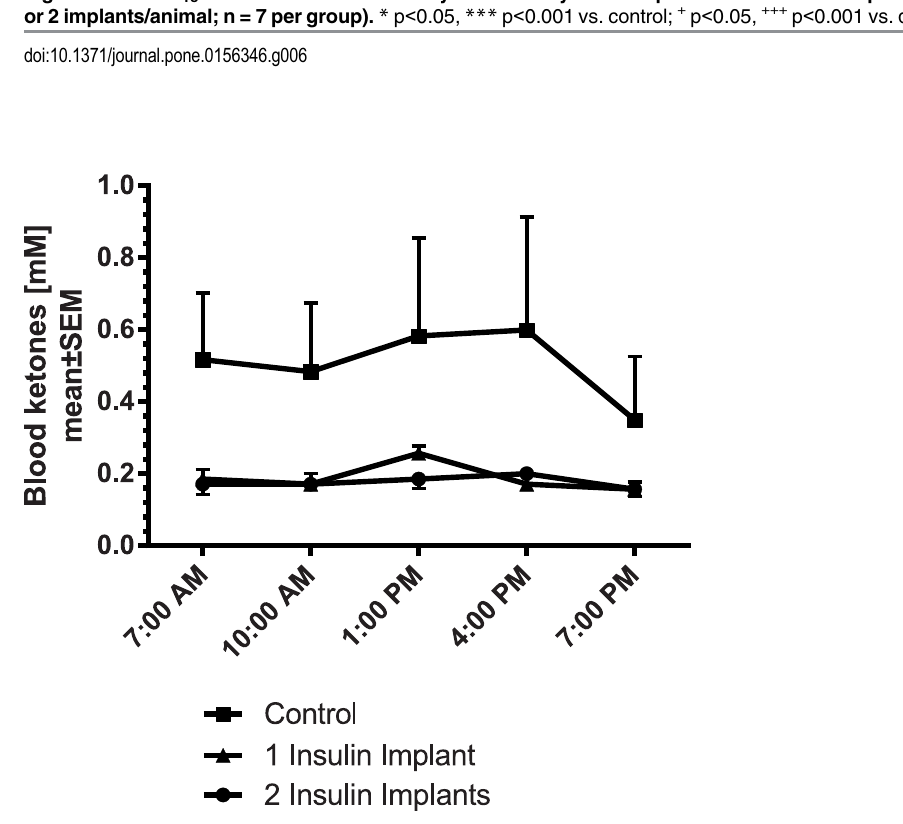
Fig 7. Blood ketone profile in STZ-diabetic rats 26 days after implantation of insulin implants (1 or 2 implants/animal; n = 7 per group). * p < 0.05, ** p < 0.01, *** p < 0.001 vs. control.